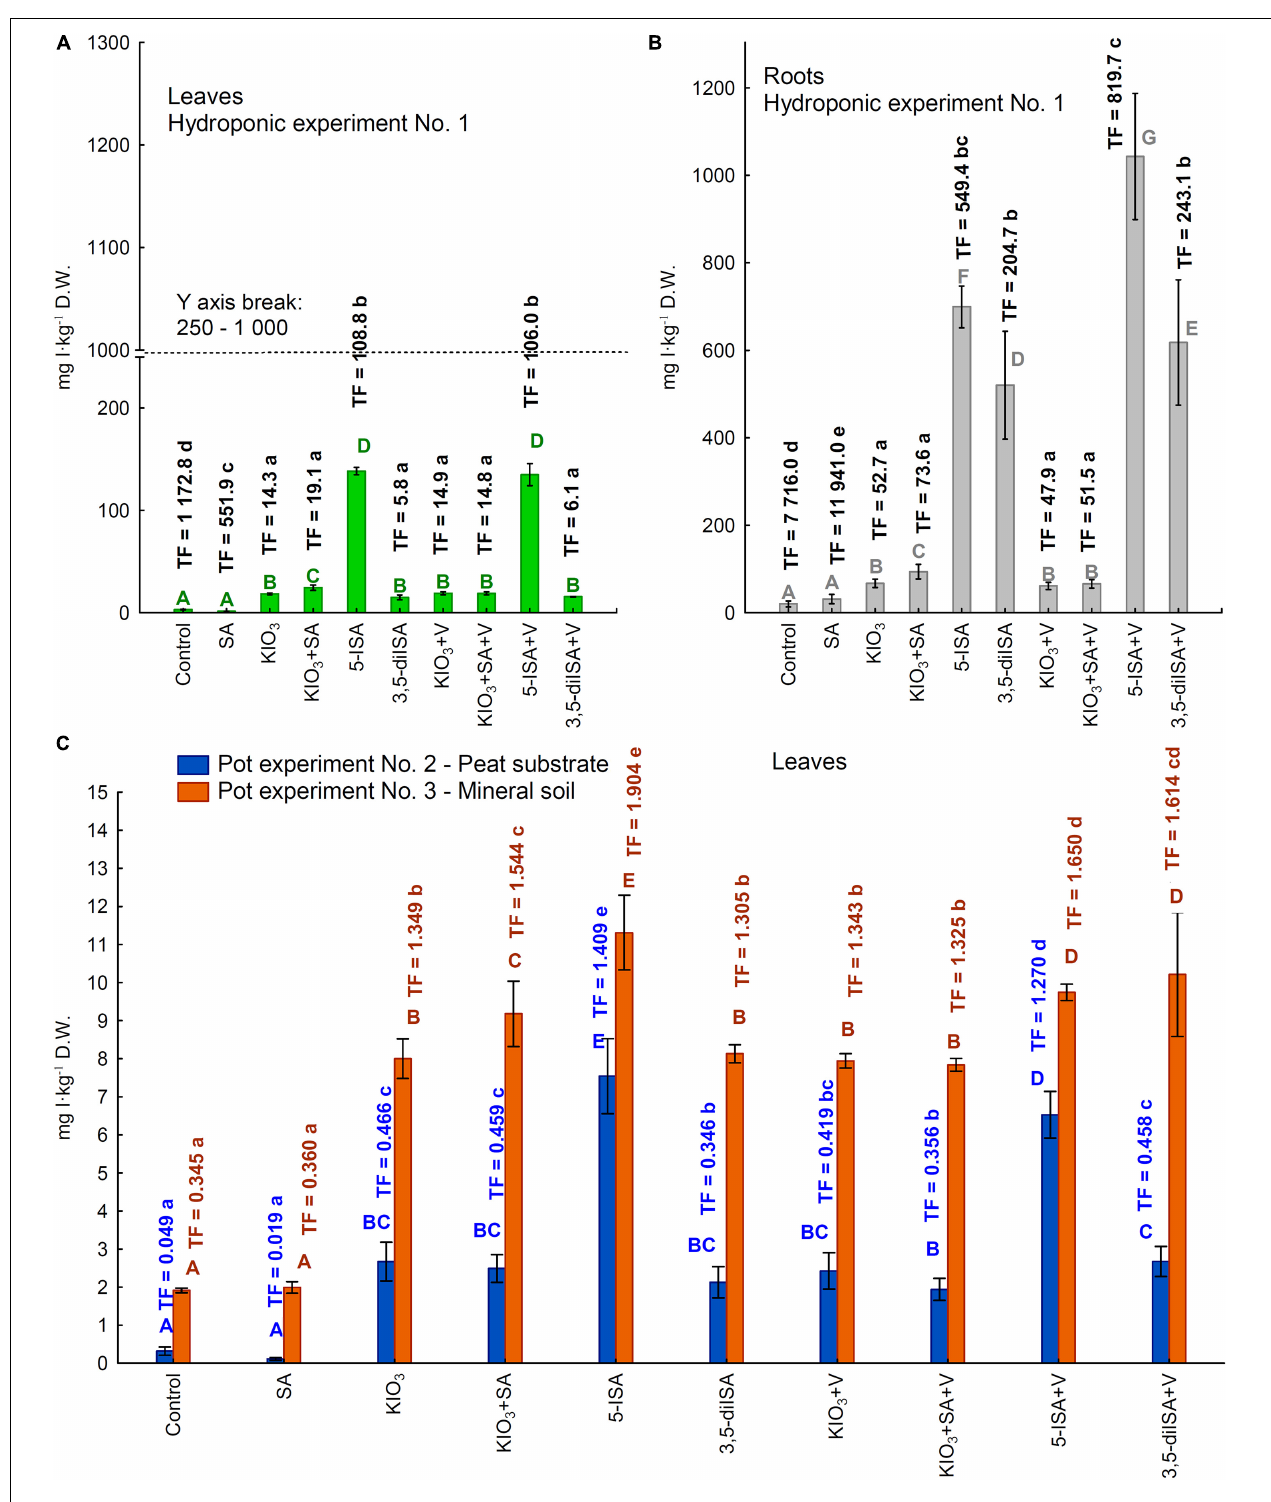
FIGURE 2 | Concentrations of iodine in leaves /heads/ (A) and roots of lettuce (B) cultivated in hydroponic NFT Experiment No. 1 as well as in leaves of plants cultivated in pot Experiment No. 2 and 3 (C) . Transfer factor /TF/ of iodine to roots and leaves /heads/ in the all experiments. Means followed by different letters for treatments, separately for each experiments differ significantly at P < 0.05. Color-coded capital letters for iodine content (green and gray for leaves and roots in Experiment 1 and blue and orange for leaves in Experiments 2 and 3); lowercase letters in the same colors for the TF factor in these experiments. Bars indicate standard error ( n =